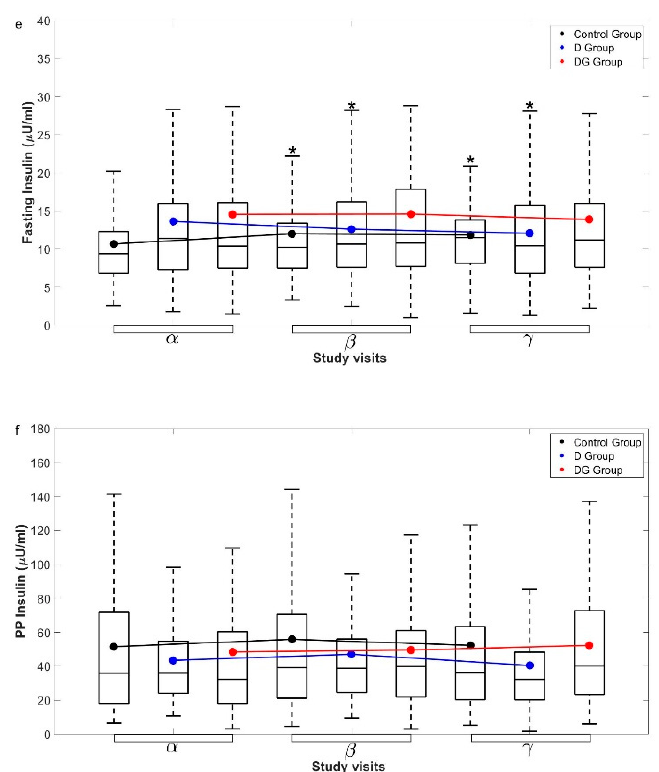
Figure 4. Longitudinal changes in glycemic parameters . The measured data for ( a ) 8-OHdG, ( b ) fasting glucose, ( c ) PP glucose, ( d ) HbA1c, ( e ) fasting insulin, and ( f ) PP insulin concentrations from Control, D, and DG groups at α , β , and γ visits are shown here with box and whiskers plots. Mean (black circles for Control, blue for D, and red for DG groups) and IQR of the data are overlaid over the corresponding box plot. The group-wise means at different visits of a group are connected using solid lines with the same color. Significance levels (*) displayed above β , and γ visits denote the comparisons with α visit using permutation tests. Significance levels are * p < 0.05, ** p < 0.01, and *** p < 0.001 for respective comparisons. Abbreviations used here are, 8-OHdG—8- hydroxy-2-deoxy guanosine, PP glucose—postprandial glucose, HbA1c—glycated hemoglobin, PP insulin—postprandial